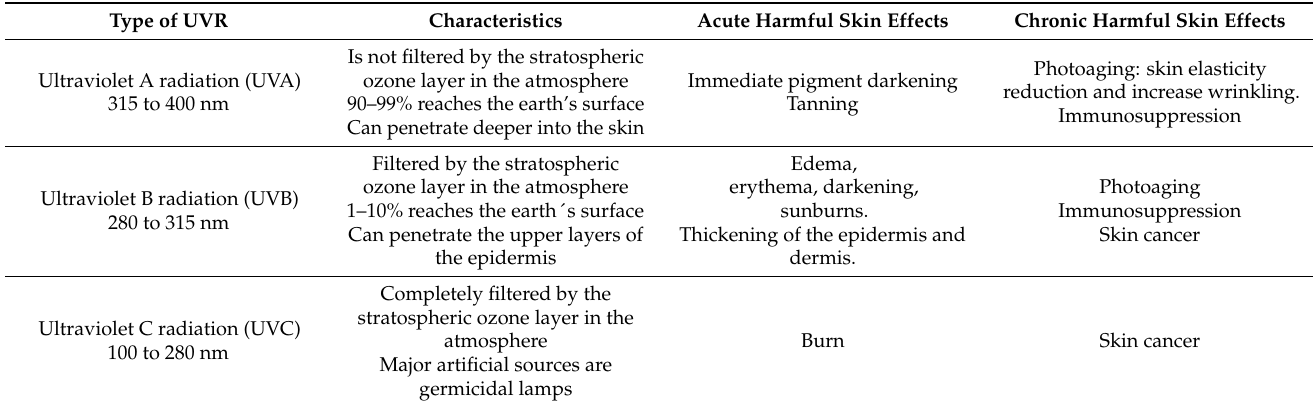
Table 1. Ultraviolet radiation classification, characteristics and harmful effects 1